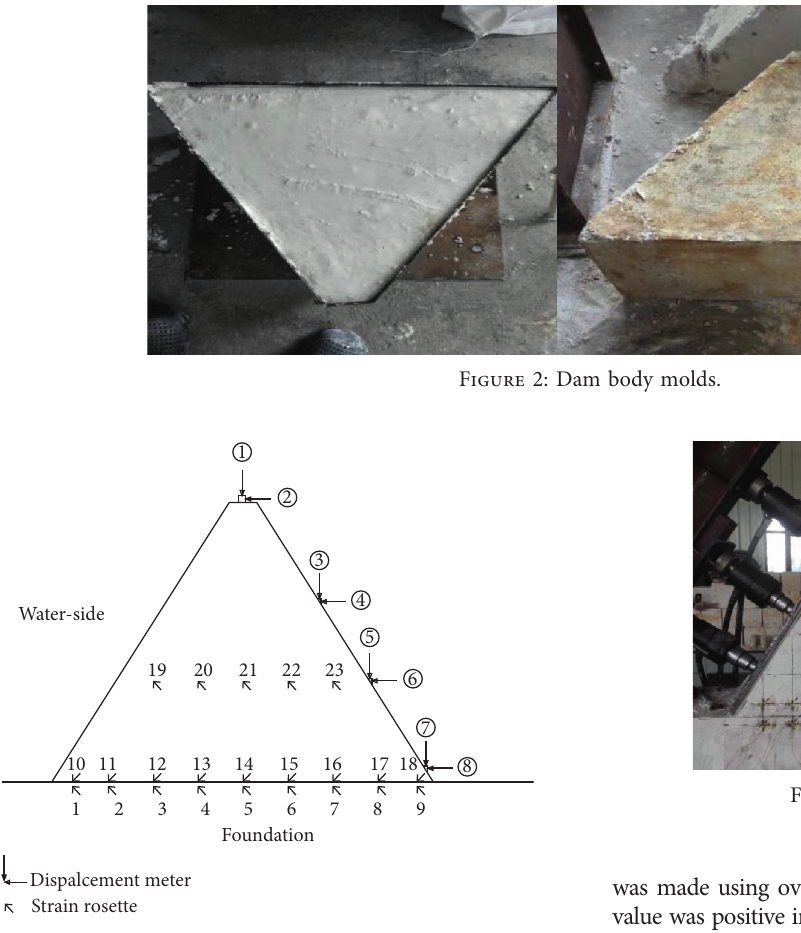
Figure 3: Measurement system.